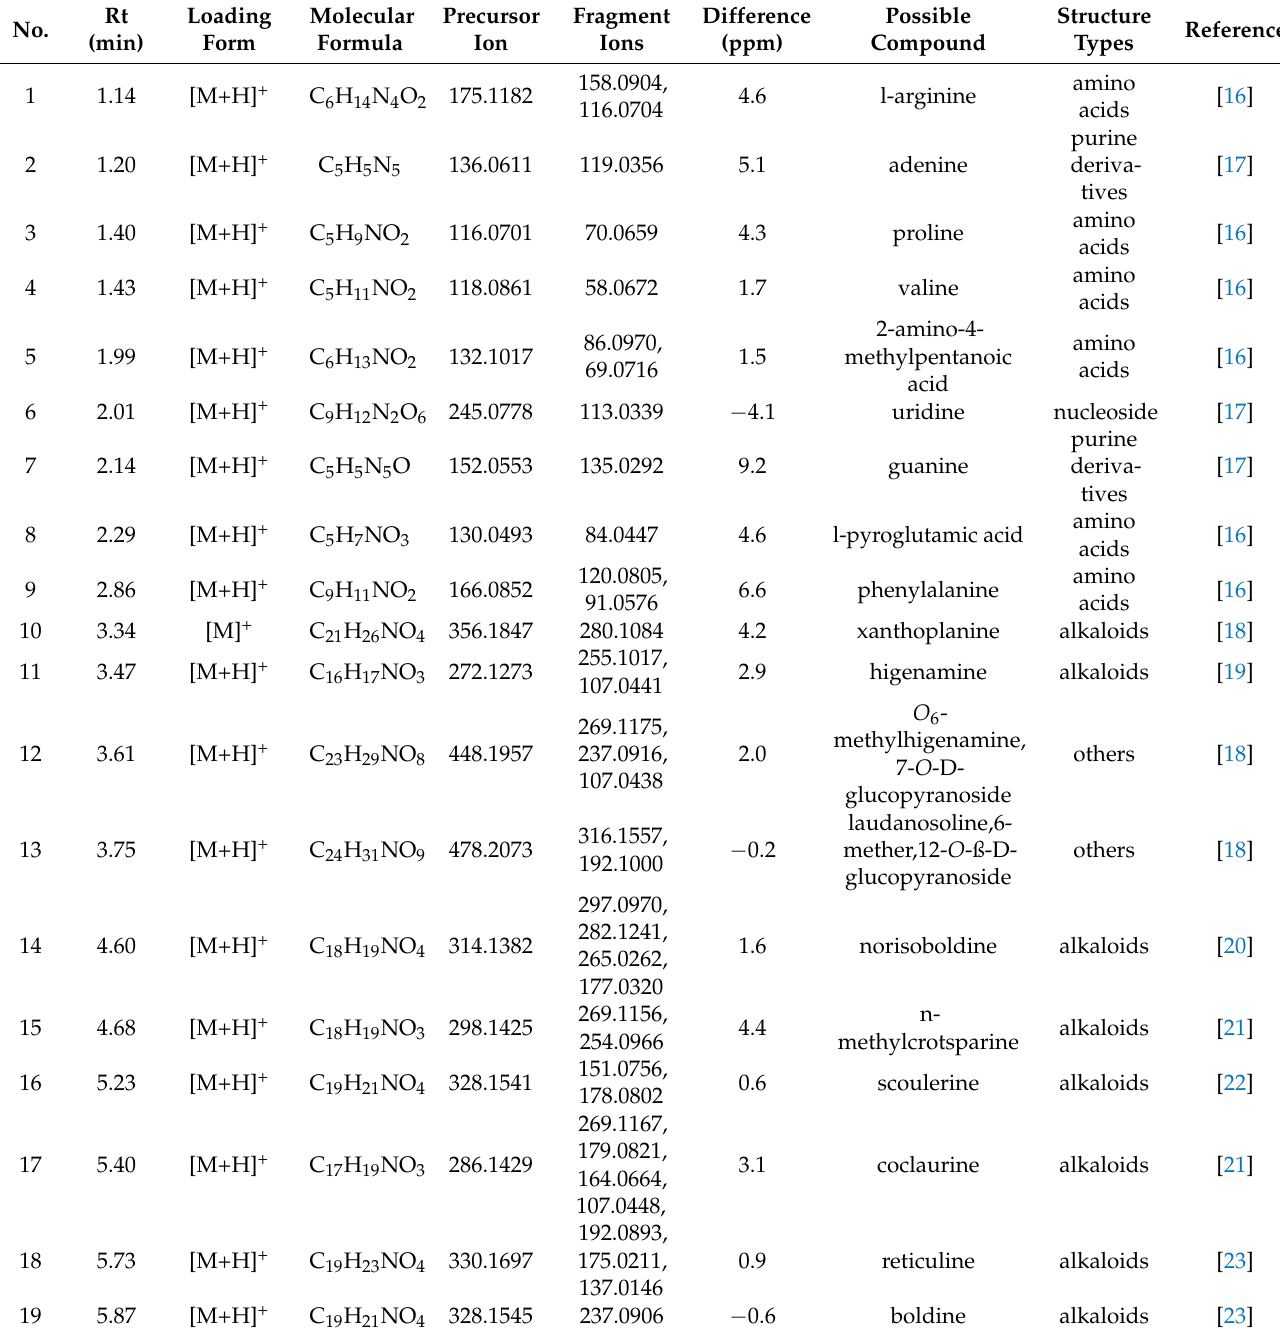
Table 2. Possible non-volatile chemicals of S. tetrandra by UHPLC-Q-TOF-MS/MS